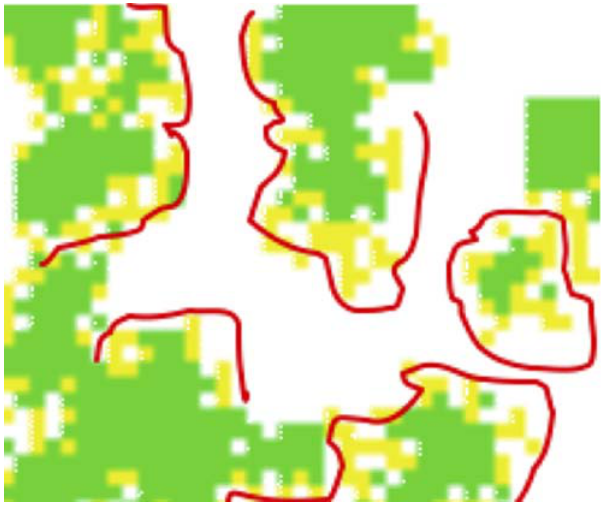
Figure 3. Zoomed-in version of upper left hand section of a snapshot at generation 1000. B/C=0.62, help=0.09. Red lines outline some cases in which nonproducers exist at the boundary between empty space and clusters of altruists. In all figures, yellow=- nonproducers, green=producer, white=empty slot.